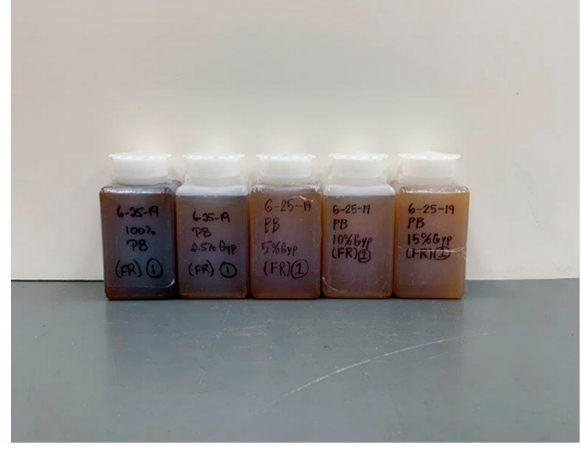
Figure 1. FGD gypsum treatment effects on clarity of leachate water after a leaching event. Table 1. Temporal changes in dissolved P concentration leaching losses observed over time from containers in 2019 as affected by FGD gypsum mixed with medium or placed at the bottom of containers fertilized with a fast release fertilizer. Application Method